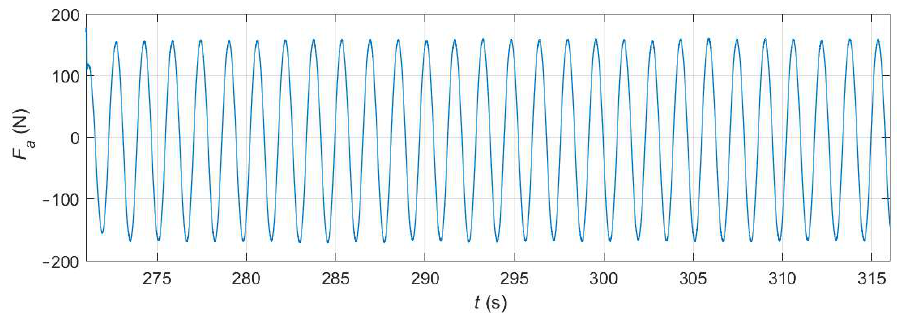
Figure 13. Experimental time series of the actuator force.